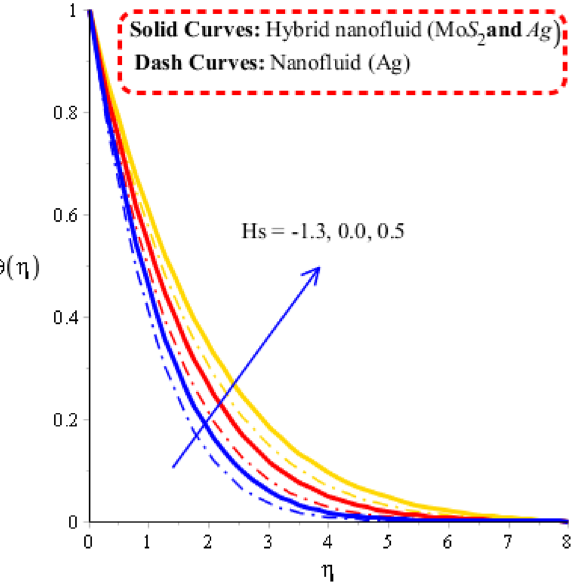
1.5, (cid:31) 1.7, γ 2.3, Fr 0.5, Pr 204, (cid:31) 2.1, ∗ = = = = = =